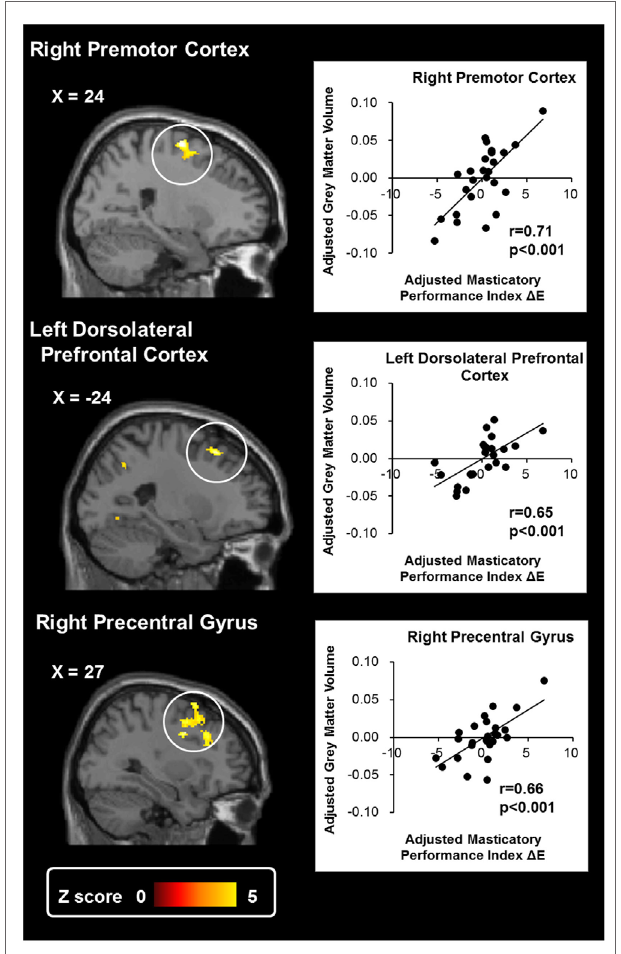
FigUre 1 | results of the voxel-based morphometry of gray matter volume . The whole-brain exploratory analysis revealed significant activation at the right premotor cortex, the left dorsolateral prefrontal cortex, and the right precentral gyrus. The gray matter density of these regions was significantly positively correlated with masticatory performance. The scatter plots show the association between the masticatory performance index ( Δ E) and the gray matter volume of each region. The masticatory performance index and gray matter volume were adjusted to remove the effects of age, gender, and total brain